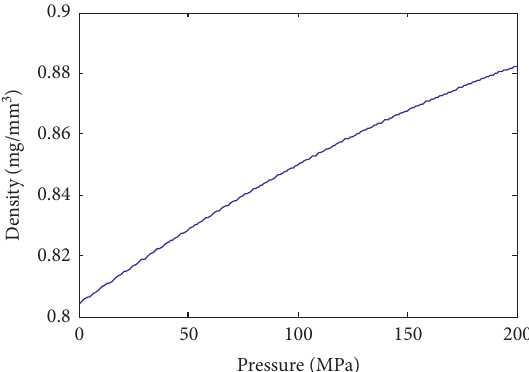
Figure 3: Relationship between the pressure and density of a certain